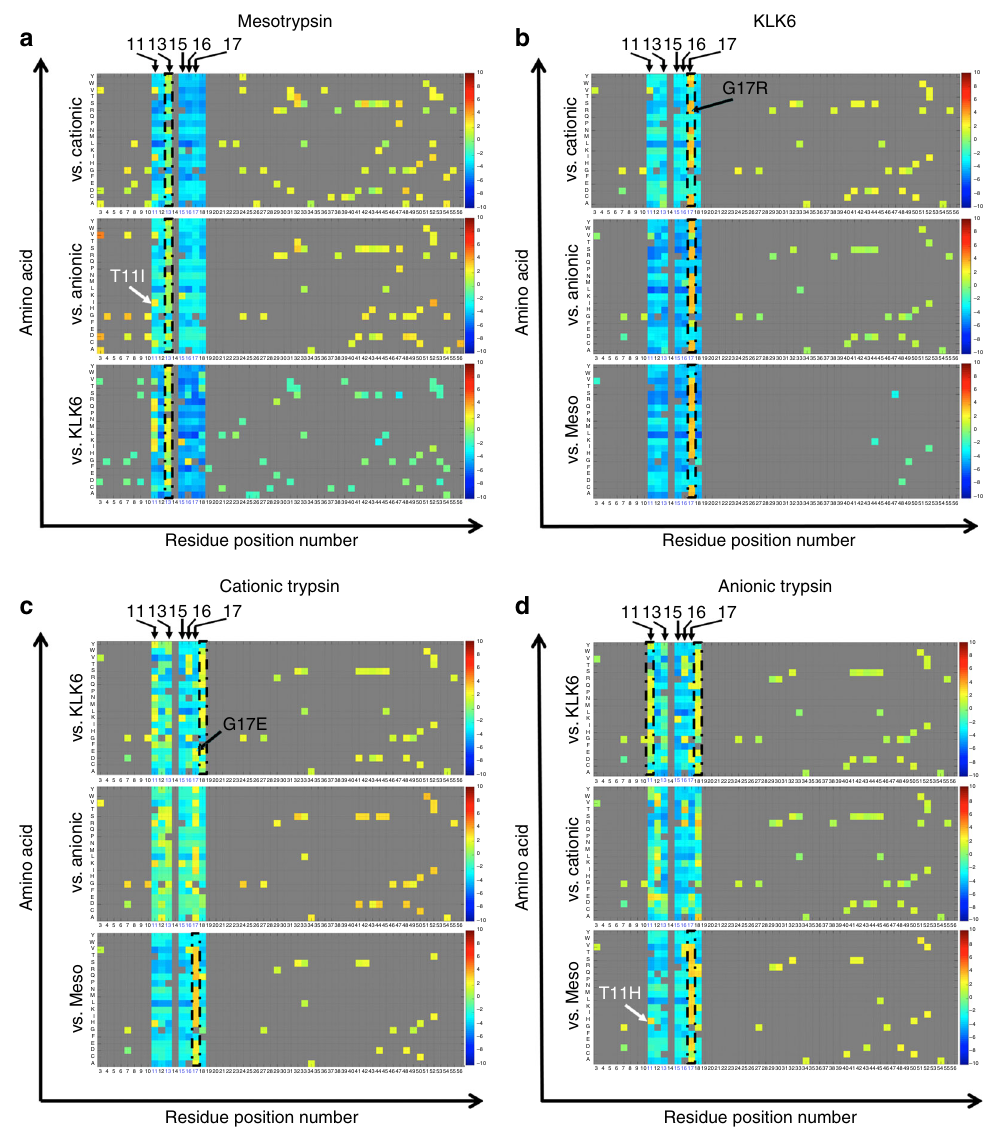
Fig. 2 Single mutation selectivity landscape of APPI-3M. The colors in the heatmaps indicate the enrichment ratio (de fi ned as the frequency of a certain mutation in the sorted library divided by its frequency in the naive library) and represent the effect of a single-amino acid substitution on APPI-3M selectivity toward one serine protease ( a : mesotrypsin, b : KLK6, c : cationic trypsin, and d : anionic trypsin) versus the other three. The different colors of the heatmaps correspond to the scale shown on the right of each panel and indicate log2 of the enrichment ratio [yellow and red: positive (increased selectivity); green: negative (decreased selectivity)]. The position of the substituted amino acid is shown on the X axis and the substituting amino acid is shown on the Y axis. Meso: mesotrypsin; Cationic: cationic trypsin; Anionic: anionic trypsin. See Supplementary Figure 3 for further